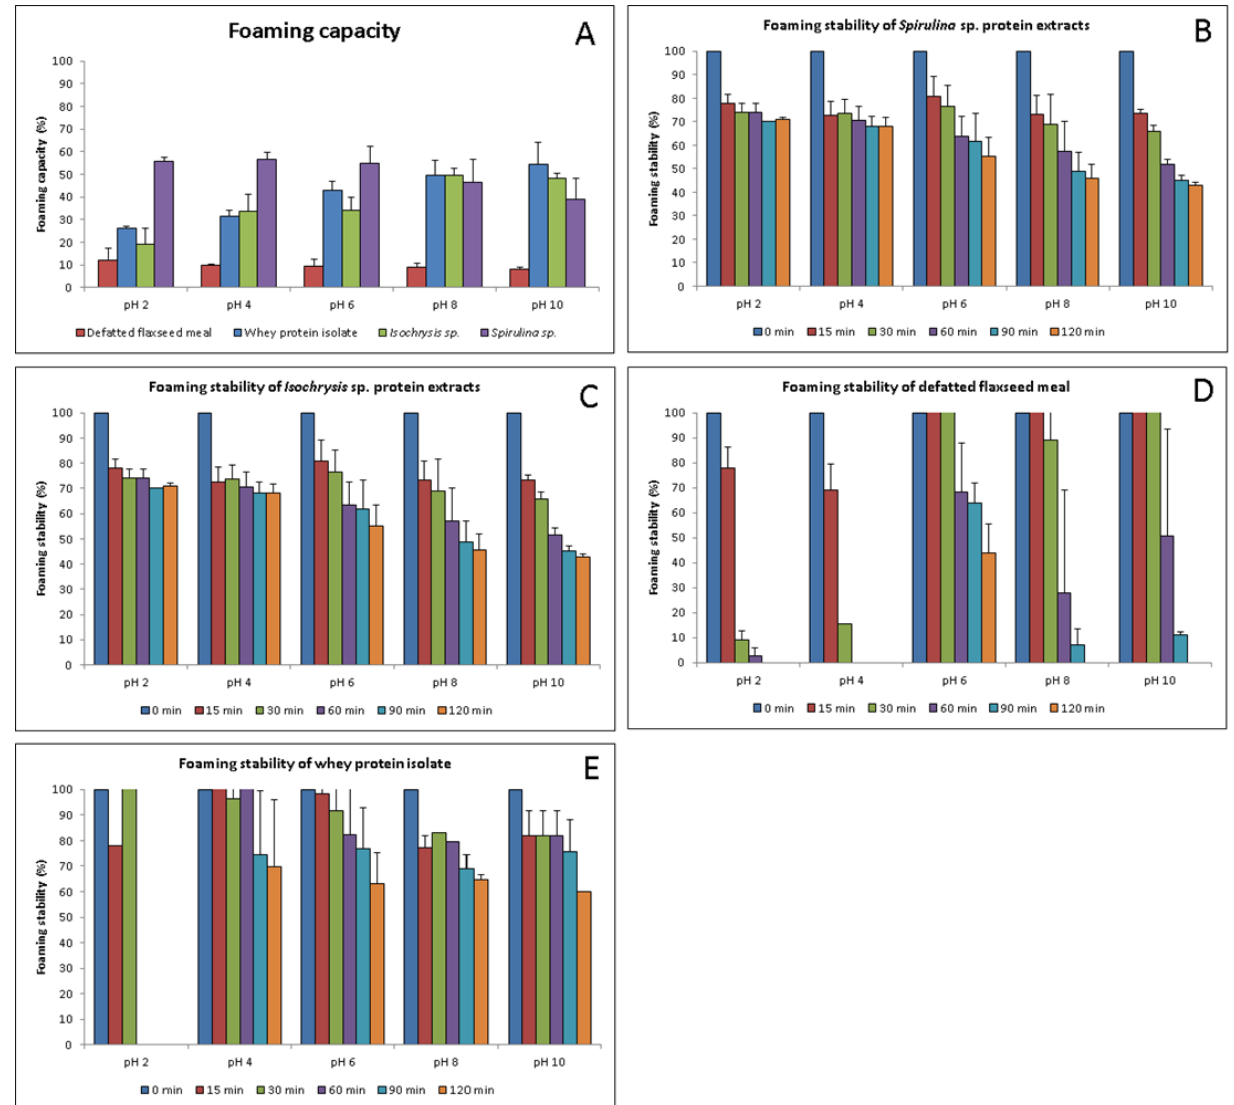
Figure 1. Foaming capacity ( A ), as well as foaming stability of Spirulina sp. ( B ), Isochrysis sp. ( C ), flaxseed meal ( D ) and whey protein isolate ( E ) (n = 3).